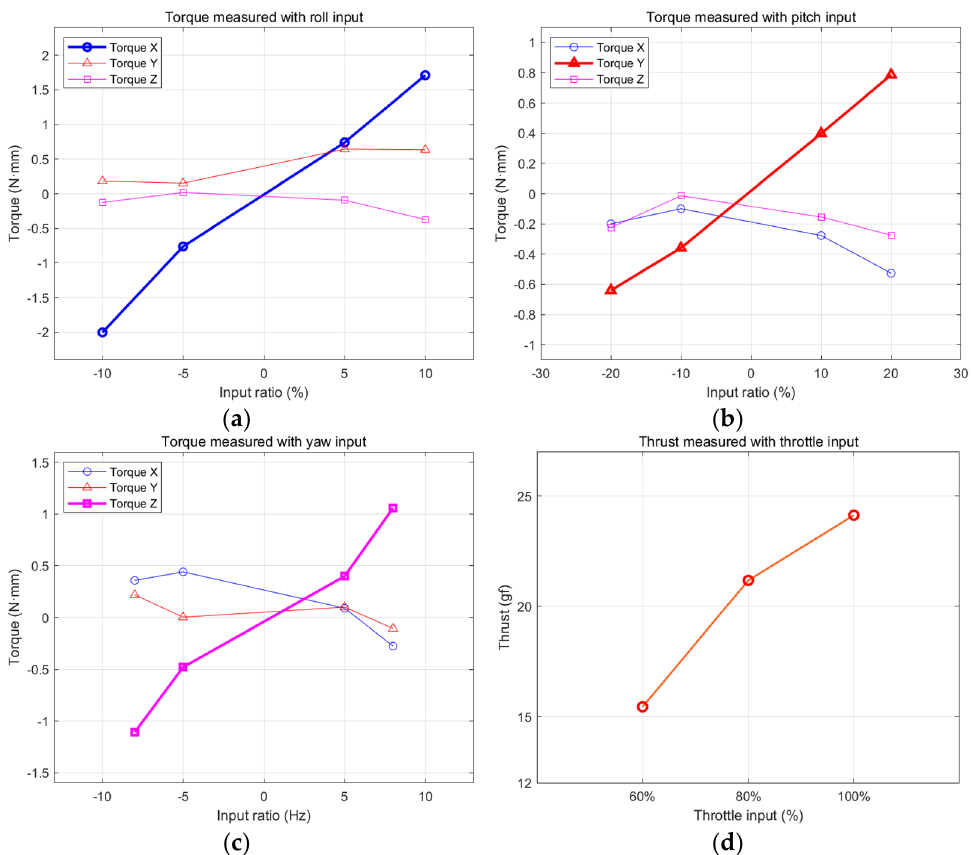
Figure 10. Steady state torques and lift force: ( a ) torques with roll command input; ( b ) torques with pitch command input; ( c ) torques with yaw command input; ( d ) lift force with 60%, 80%, and 100% thrust